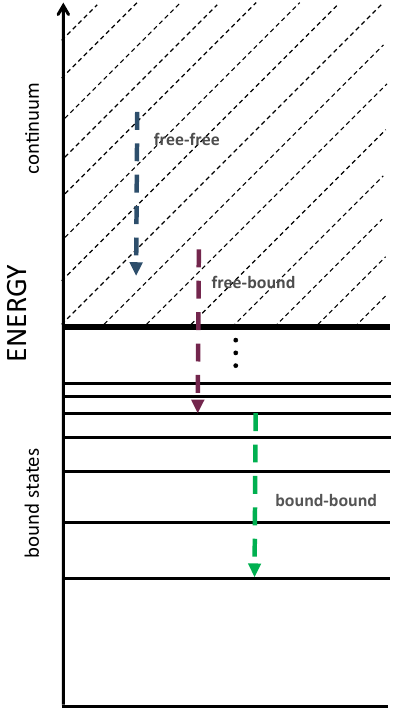
Figure 3. Energy scheme for free-free, free-bound, and bound-bound electron